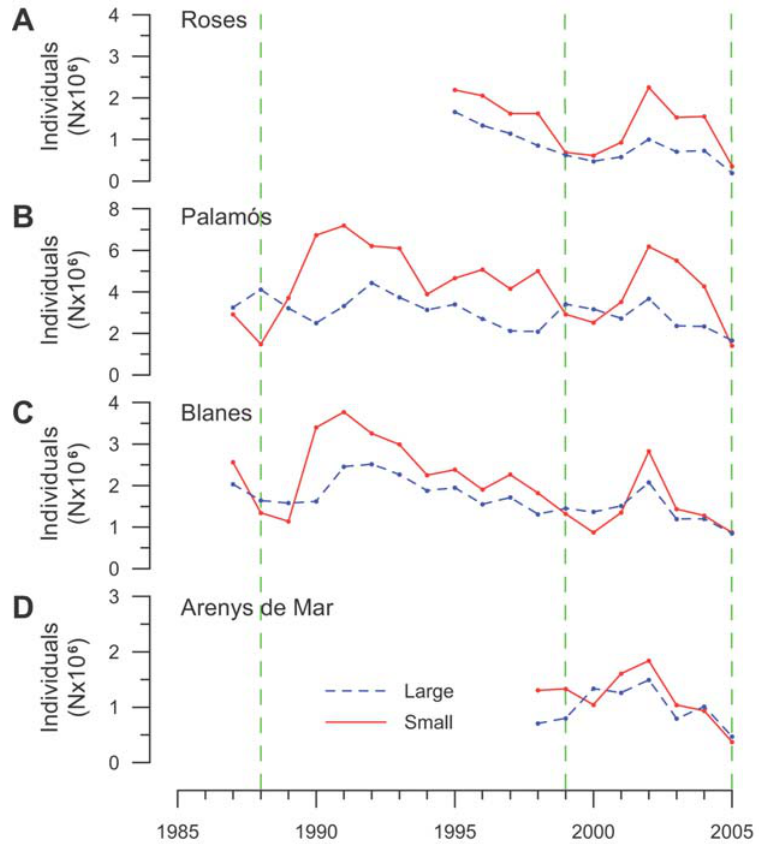
Figure 5. Temporal evolution in population structure. (A–D) Estimation of the abundance of small (continuous red line) and large (dotted blue line) individuals of Aristeus antennatus derived from the annual landings in the studied harbors. Green dashed lines indicate the years when major cascading events occurred. The temporal evolution of the population structure of Aristeus antennatus in all harbors was linked to those cascading events. The number of small individuals increased two and three years after the event, prior the increase in the number of large individuals, indicating that cascading events enhance the recruitment process of this species.